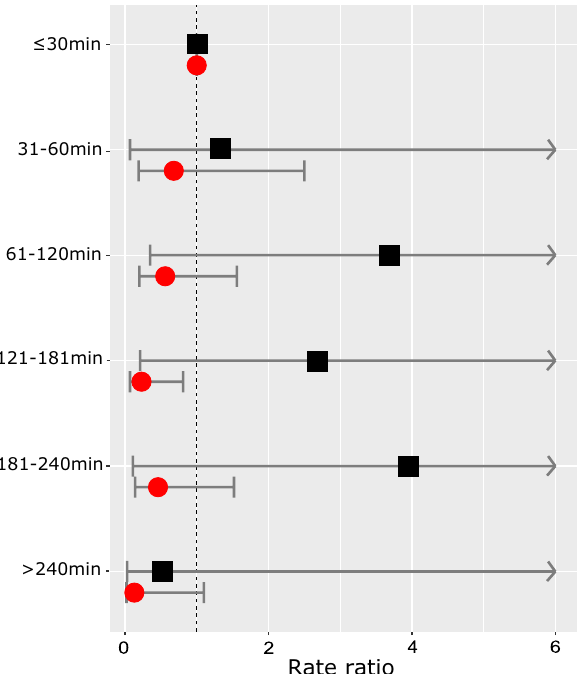
Figure 4. Results of three-level mixed logistic regression of fever (38.5 °C or 39.0 °C) to start of antibiotics (TTA) and safety relevant events, stratified by severity of the disease at presentation. Legend: Displayed are rate ratios and 95% confidence interval (x-axis) for the predefined time intervals (y-axis). Black squares indicate rate ratios of patients with severe disease at presentation (defined as severe sepsis or reduced clinical condition); red circles indicate rate ratios from patients without severe disease at